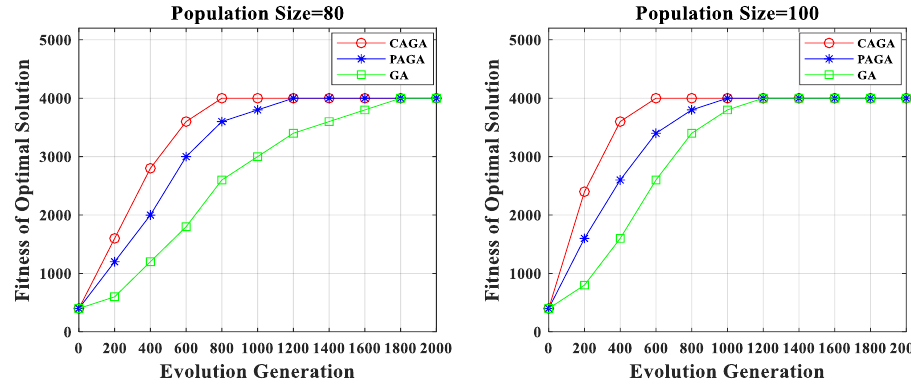
Figure 8. The performance of improved GA.